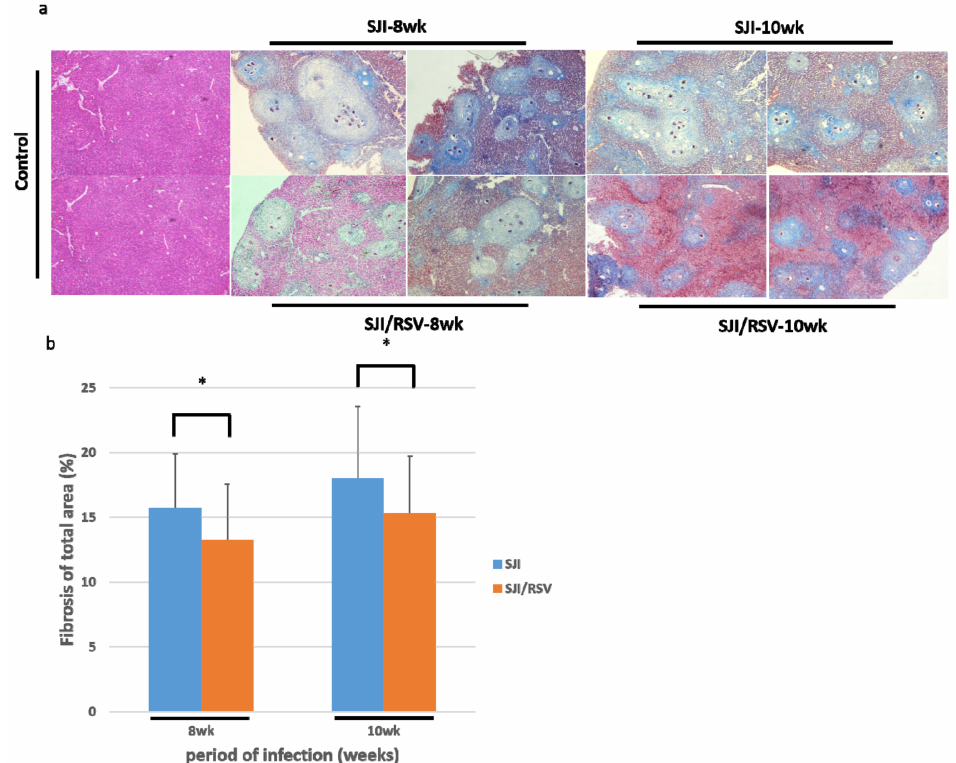
Figure 3. Pathological changes in liver tissues at 8 and 10 weeks after S. japonicum infection. ( a ) Representative images of Masson-stained liver tissue. Masson trichrome staining resulted in the collagen fiber being stained blue; cell nuclei, black; and background, red (original magnification, 100 × ). ( b ) The quantitative changes were measured with the ImageJ plugin software. RSV reduced collagen deposition compared to the non-treated mice (uninfected mice were used as the normal control group). Results are presented as mean ± SD (n = 5, with 50 fields per group). * p < 0.05, unpaired Student t